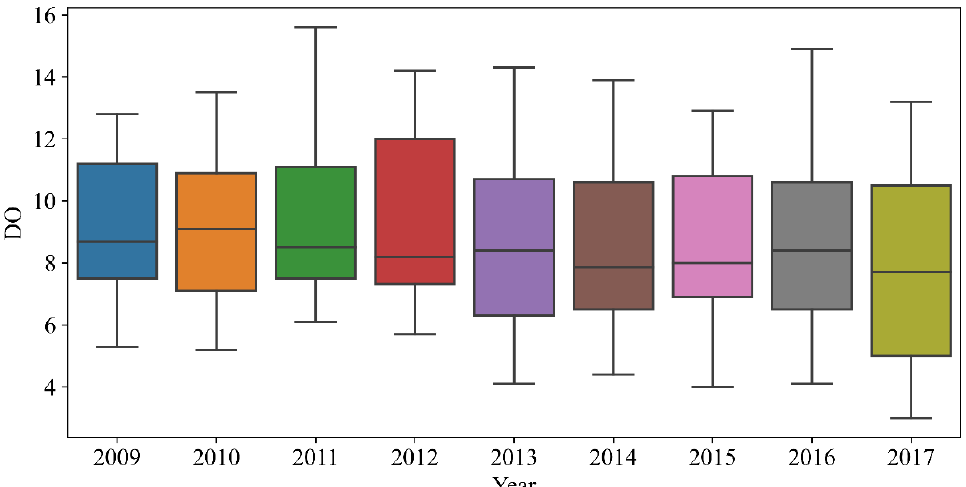
Figure 2. Annual data distribution of water quality indicator DO.